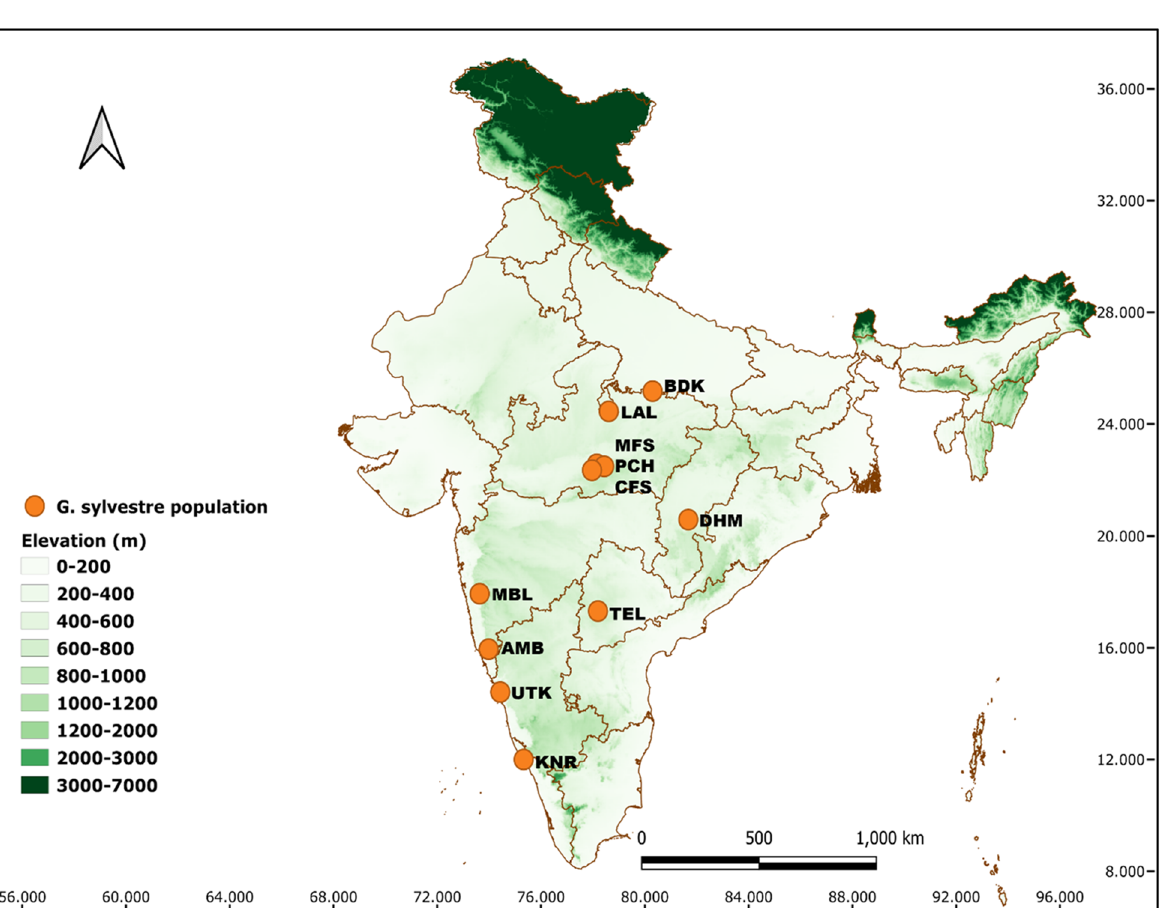
Fig. 1 Location map prepared using QGIS v3.14 “Pi” for the collected wild populations of G. sylvestre in India. Population codes are as given in